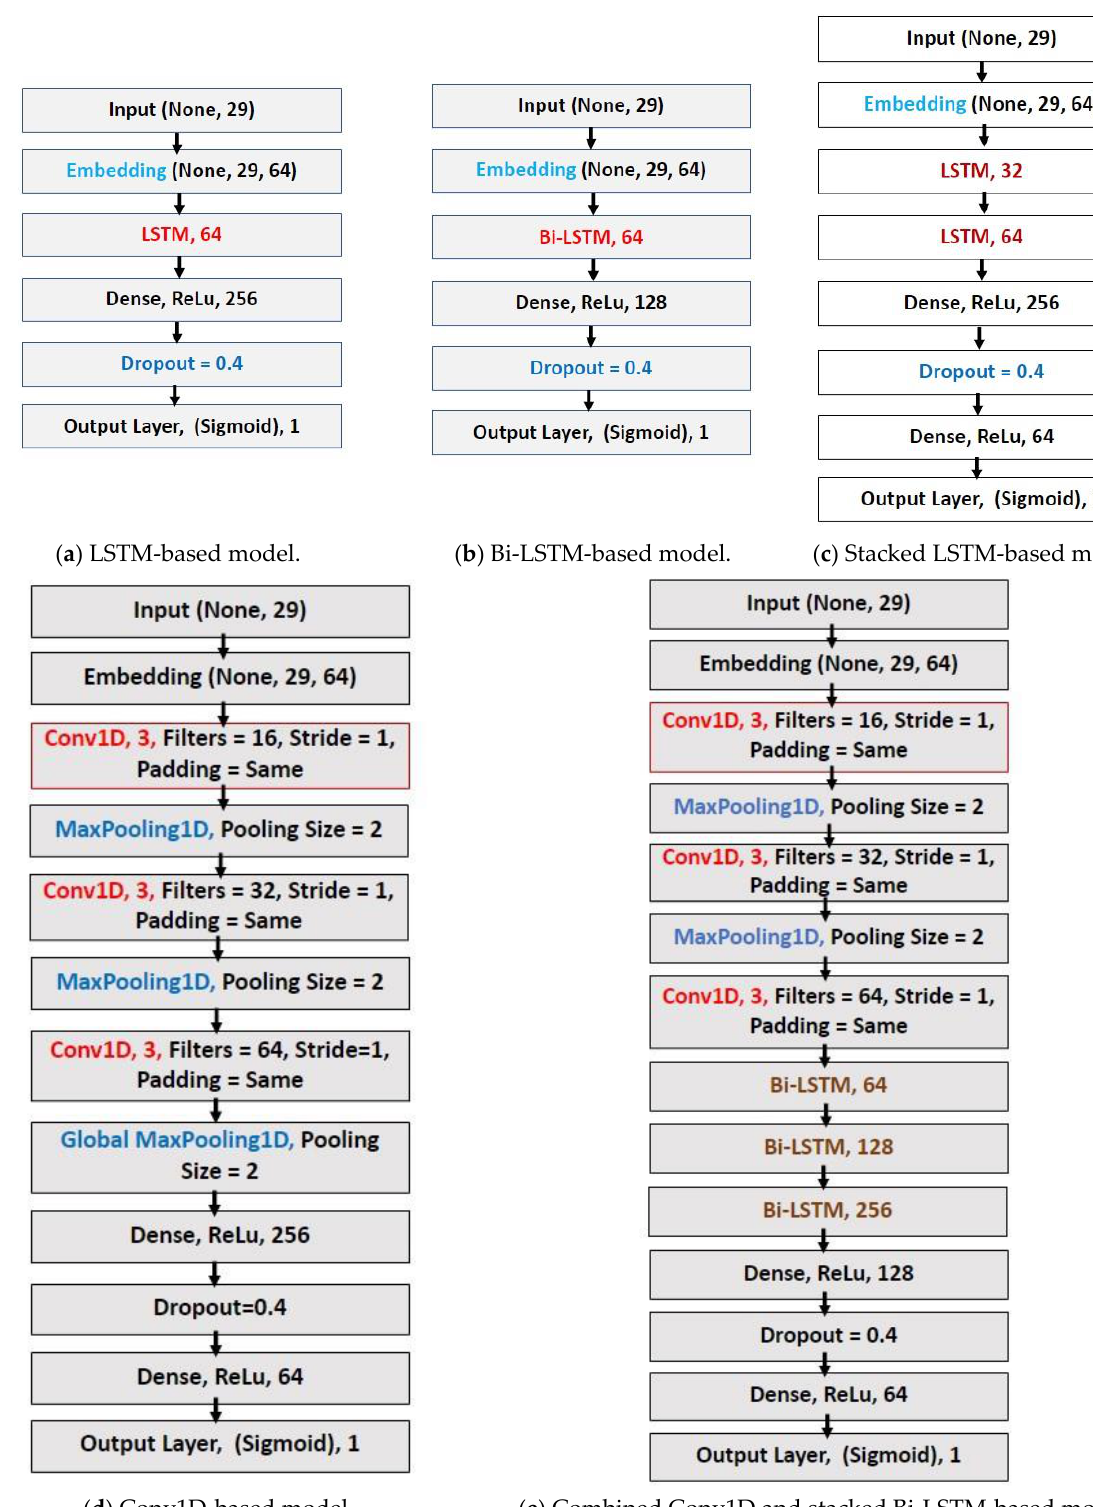
Figure 3. ( a – e ) Layer visualization of five different DNN models.